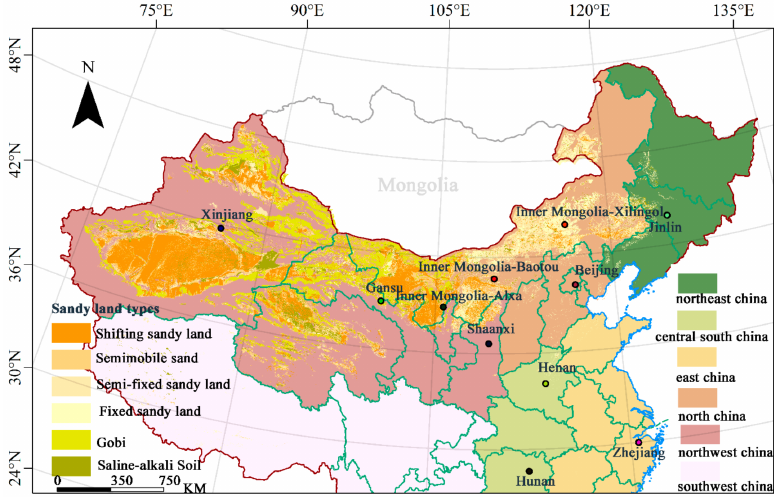
Figure 1. Geographical zoning and sand distribution in the study